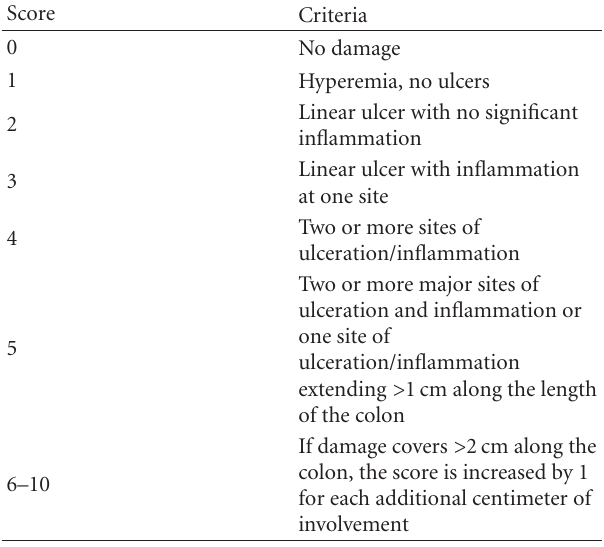
Table 1: Criteria for assessment of macroscopic colonic